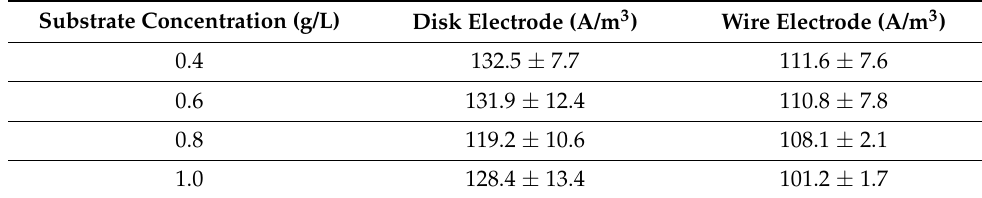
Figure 2. Current densities of MECs at different substrate concentrations. Table 1. Volumetric peak current density at different substrate